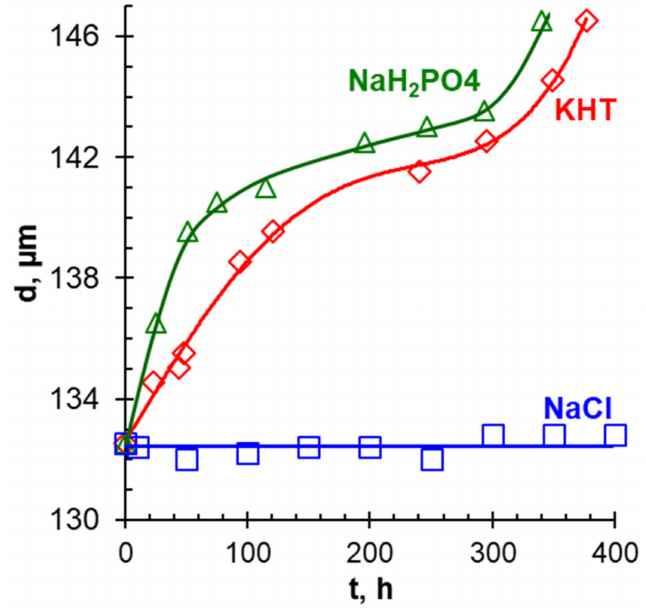
Figure 24. The AMX-Sb anion-exchange membrane (Astom, Yamaguchi, Japan) thickness versus soak- ing time in 0.02 M sodium chloride (NaCl), potassium hydrotartrate (KHT), and sodium hydrogen phosphate (NaH 2 PO 4 ) solutions. Reproduced from